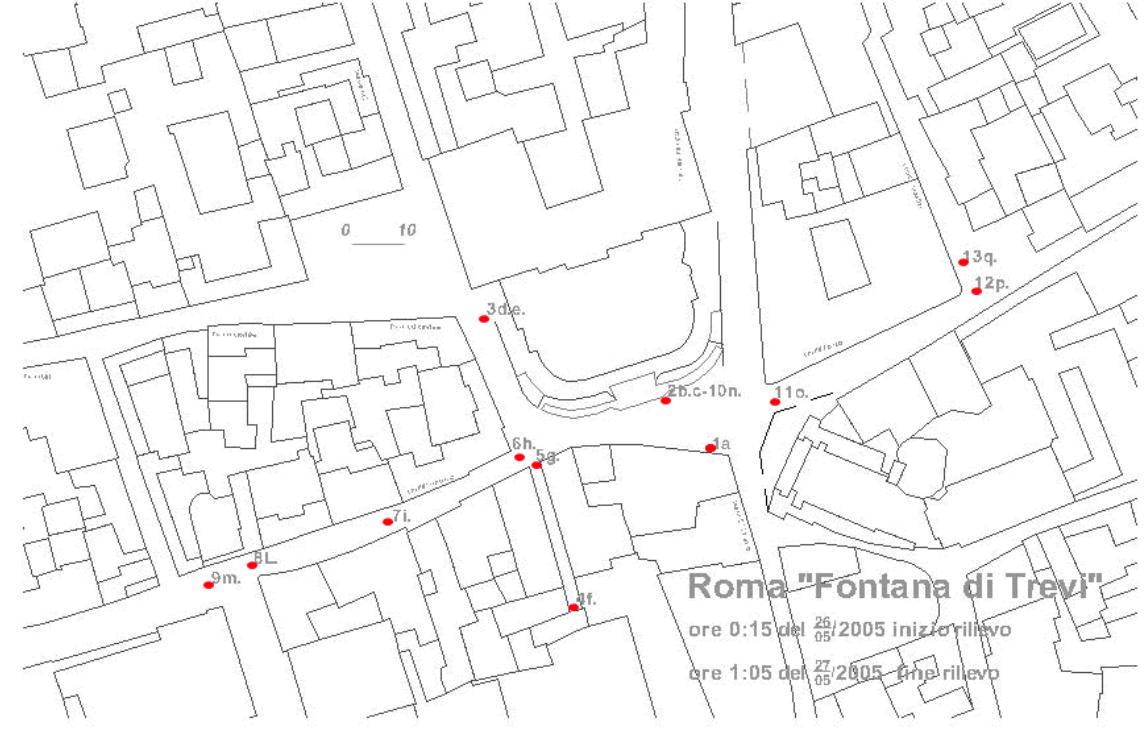
Figure 10: Piazza fontana di Trevi, spatialization of measures: the spots of sonometer measurements performed by G. Mueller.